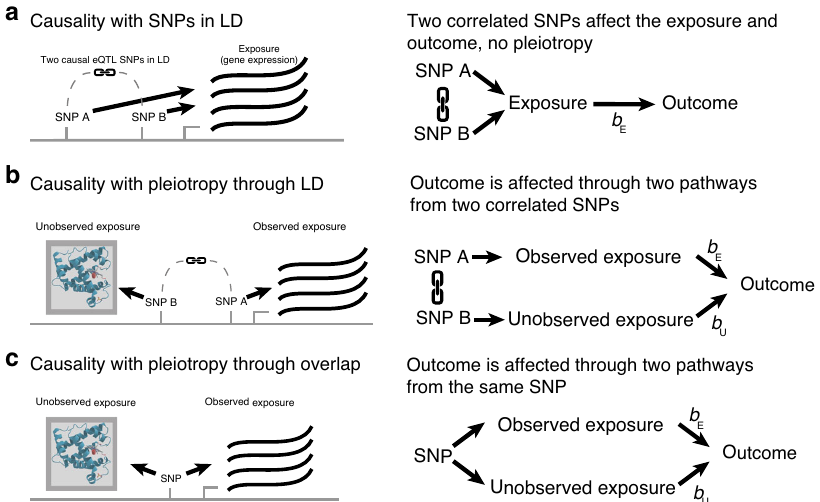
Fig. 2 Typical scenarios of pleiotropy in causal inference of gene expression changes as an exposure. Typical scenarios to consider when performing causal inference in gene expression: a expression quantitative trait locus (eQTL) single nucleotide polymorphisms (SNPs) used as instrumental variables (IVs) for the same gene (exposure) are in linkage disequilibrium (LD) and pleiotropic effects are absent, b pleiotropy is present through LD between IVs for different exposures (pleiotropy through LD), and c pleiotropy is present through overlap of the IVs (pleiotropy through overlap). In each panel, the left image shows the genomic context while the right image is a schematic diagram of the corresponding causal effects. Please note that the unobserved exposure trait does not necessarily need to be a protein product: it could be any measured or unmeasured phenotype that is regulated by the genetic